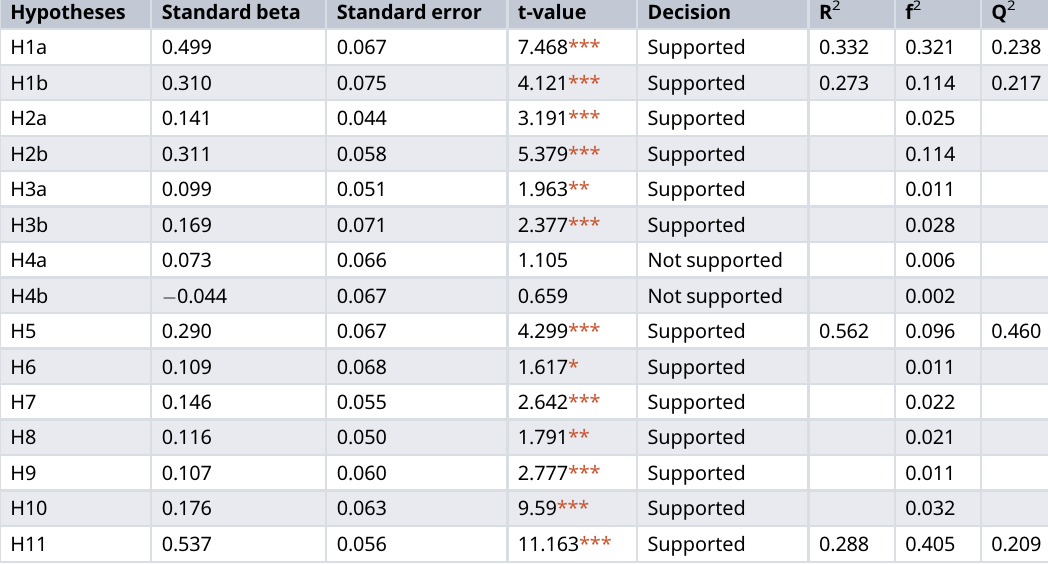
Table 2. Structural model